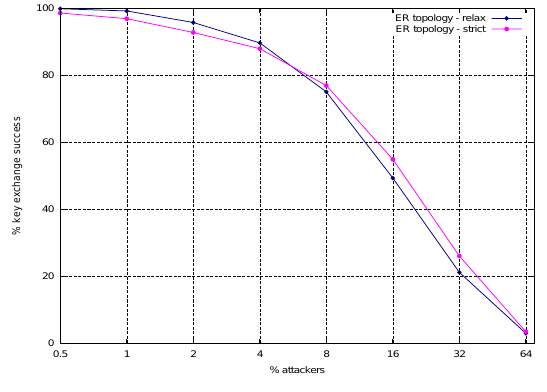
Figure 13. Comparison between the relax and strict routing modes.